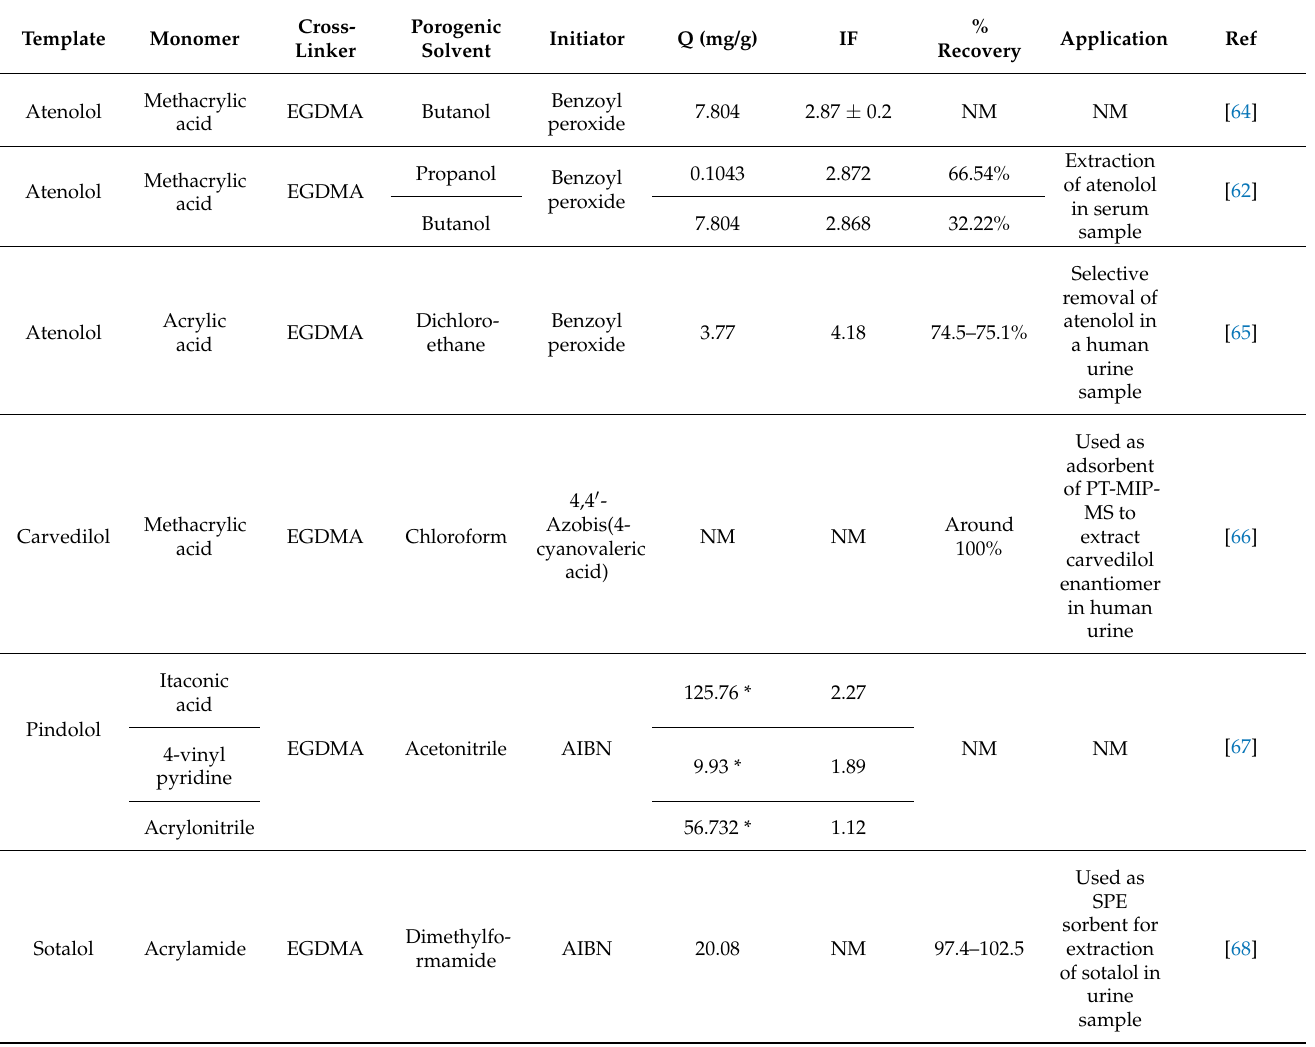
Table 4. Studies involving the synthesis of MIPs using the bulk polymerization